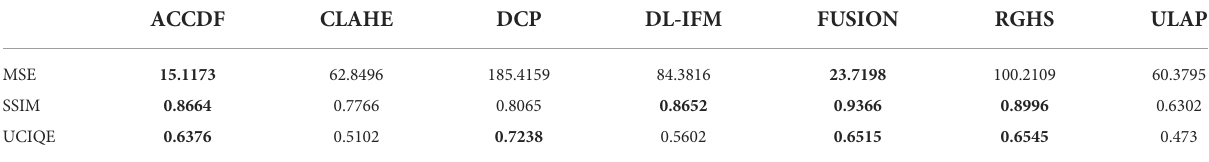
MSE, mean square error; SSIM, structural similarity; UCIQE, underwater color image quality evaluation; ACCDF, adaptive correction of channel differential and fusion; CLAHE, contrast limited adaptive histogram equalization; DCP, dark channel prior; DL-IFM, deep learning image formation model; RGHS, relative global histogram stretching; ULAP, underwater light